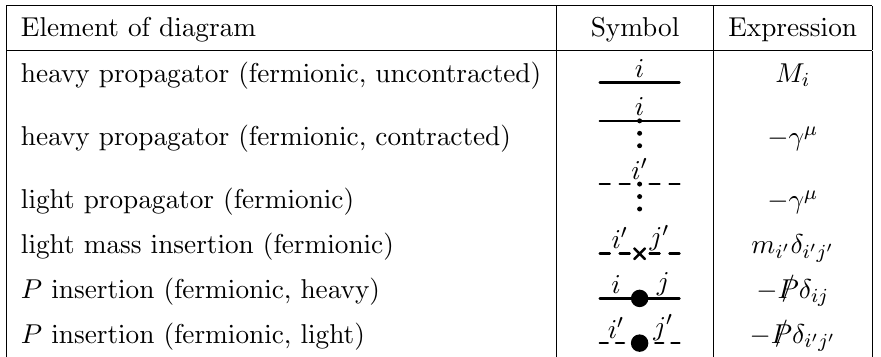
Table 4 . Additional building blocks of covariant diagrams when Dirac fermions are involved in matching, as derived in section 3.4. These are used when the quadratic operator for fermionic (cid:12)elds is not squared like in eq. (3.19). Example applications can be found in sections 4.4 and